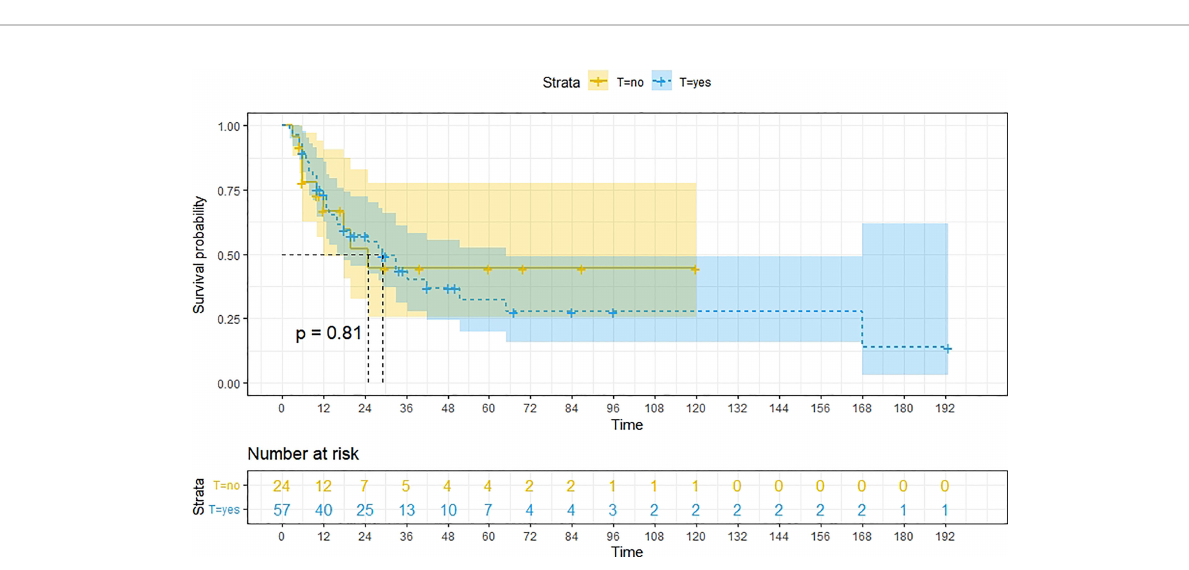
FIGURE 7 | Kaplan-Meier survival curves for OS in patients of surgery (RH+TAH) with and without other treatments. There was little difference in median OS between these two